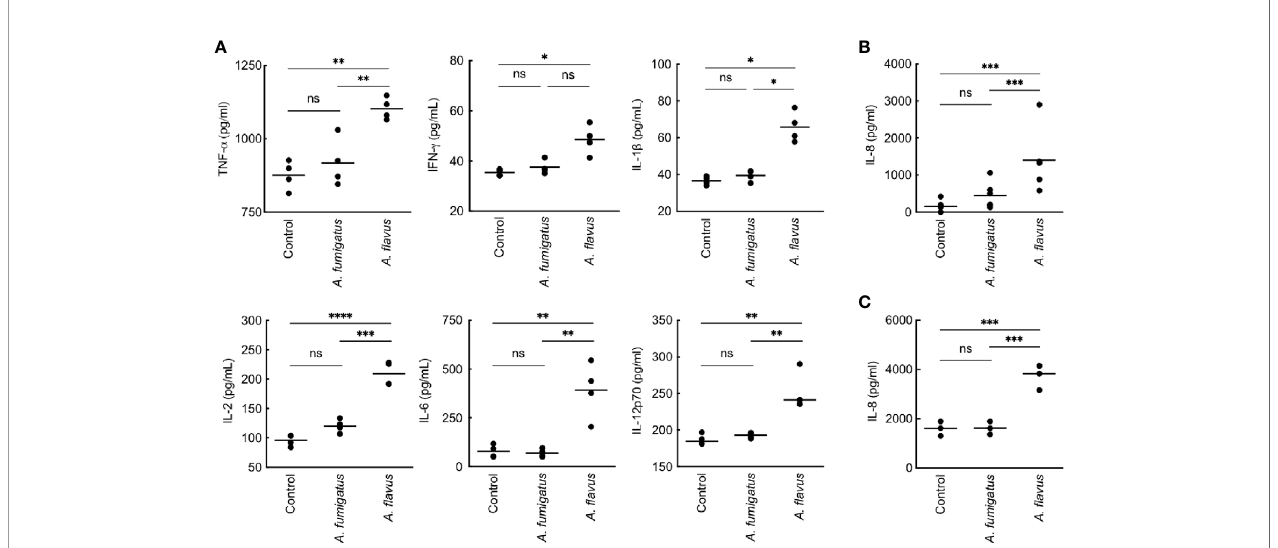
FIGURE 2 | Cytokine induction in human monocyte-derived macrophages (MDMs) by para- formaldehyde (PFA)- fi xed (inactivated) conidia. (A) Human MDMs [obtained by seeding 2x10 6 peripheral blood mononuclear cells (PBMCs) per well] of four healthy donors were co-incubated with PFA- fi xed conidia (5x10 5 per well) in complete RPMI (37°C for 20 h). The supernatants were collected for cytokine quanti fi cation (TNF- a , IFN- g , IL-1 b , IL-2, IL-6, and IL-12p70). A. fumigatus conidia did not induce cytokine production from MDMs. However, A. fl avus conidia signi fi cantly stimulated the secretion of pro-in fl ammatory cytokines TNF- a , IL-1 b , IL-2, IL-6, IL-12p70, and IL-8 (*p < 0.05, **p < 0.01, ***p < 0.005, ****p < 0.0005). While A. fl avus conidia speci fi cally stimulated the secretion of IL-8 by dendritic cells (B) and neutrophils (C) (***p < 0.005). ns – not signi fi